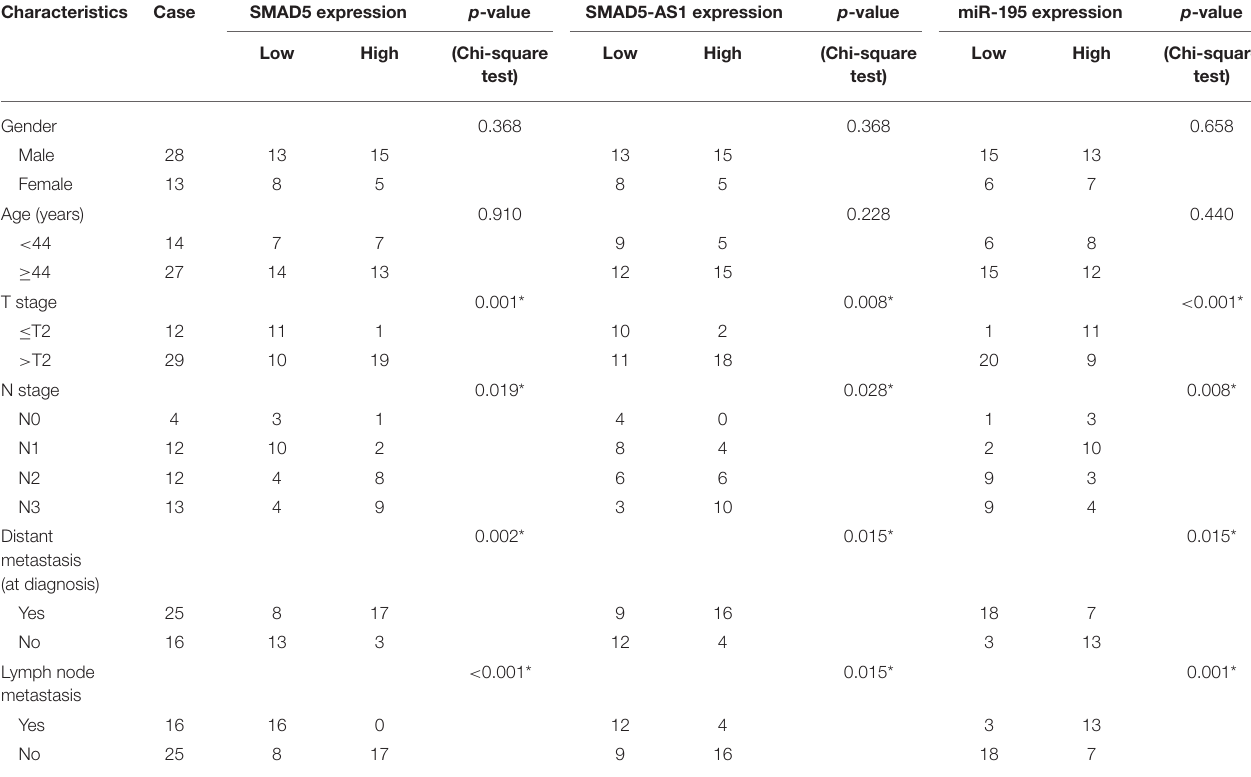
TABLE 2 | Associations between the expression of SMAD5, SMAD5-AS1, and miR-195 and the clinicopathological characteristics of patients with NPC. Characteristics